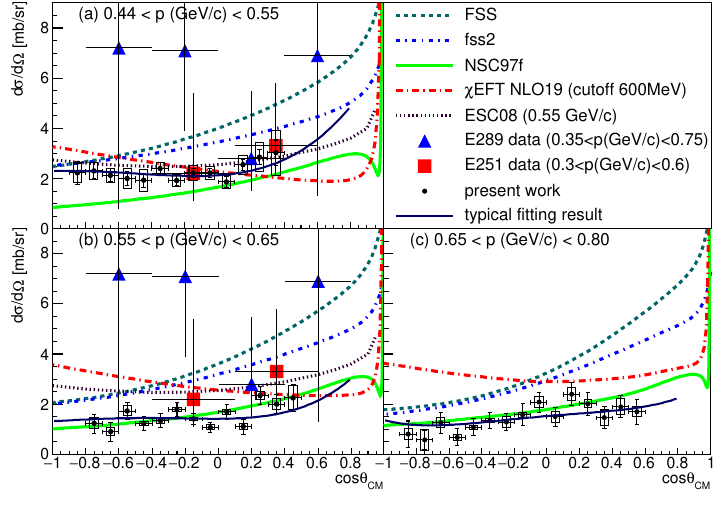
Figure 2. Derived di ff erential cross sections of the Σ + p scattering for the three momentum regions. The error bars and boxes show the statistical and systematic uncertainties, respectively. The red boxes and blue triangles shows the data of past experiments, KEK E251 and KEK E289. The navy blue lines represents the typical fi tting results in the phase shift analysis, described in 3.2. The other lines shows the theoretical